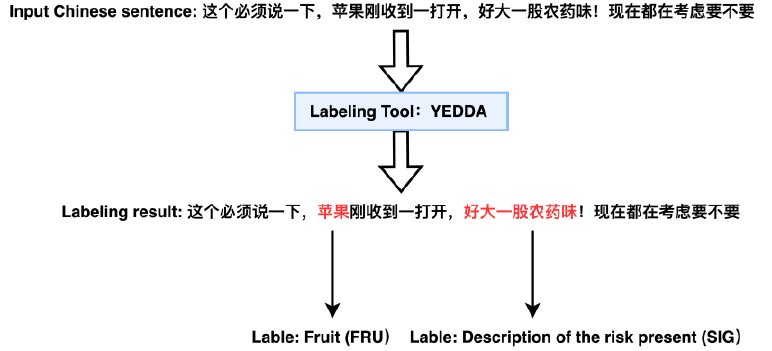
Figure 4. Manual annotation instance. The term “ 苹果 ” represents the apple, indicating the presence of risky fruit categories, labeled “ FRU ” , and “ 好大一股农药味 ” indicates that the apple strongly smells of pesticides, which is labeled as food safety risk description “ SIG ” .